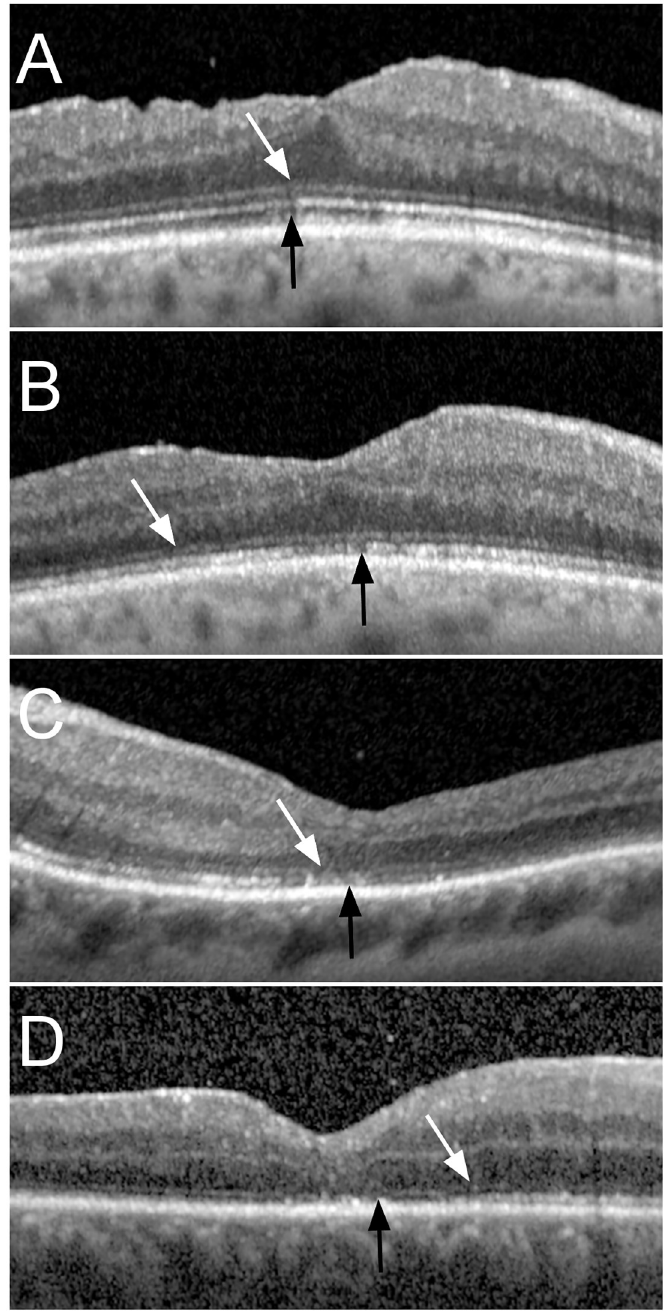
Fig 2. ELM and EZ grading. Optical coherence tomography (OCT) images of different eyes representative of the different severity grades of external limiting membrane (ELM) and ellipsoid zone (EZ) impairment. For both structures, grade 1 is defined as a normal and continuous structure, grade 2 as altered but continuous, grade 3 as interrupted and grade 4 as absent. A: ELM and EZ grade 1: Fovea 6 months after re-attachment surgery, where ELM and EZ are continuous and only show regular alterations comparable to normal eyes, with a visual acuity of 0.2 LogMAR. B: ELM and EZ grade 2: ELM and EZ are continuous with subfoveal alterations—very minor in the case of ELM—1 month after surgery, with a visual acuity of 0.4 LogMAR (same patient as in A). C: ELM grade 3 and EZ grade 3, the ELM shows small interruptions and the EZ alterations in the foveal area, 1 month after retinal detachment surgery, with a visual acuity of 0.3 LogMAR. D. ELM grade 3 and EZ grade 4: the ELM (arrow) is interrupted and the EZ is terminated outside the foveal area (arrowhead), 1 month after retinal detachment surgery, with a visual acuity of 0.4